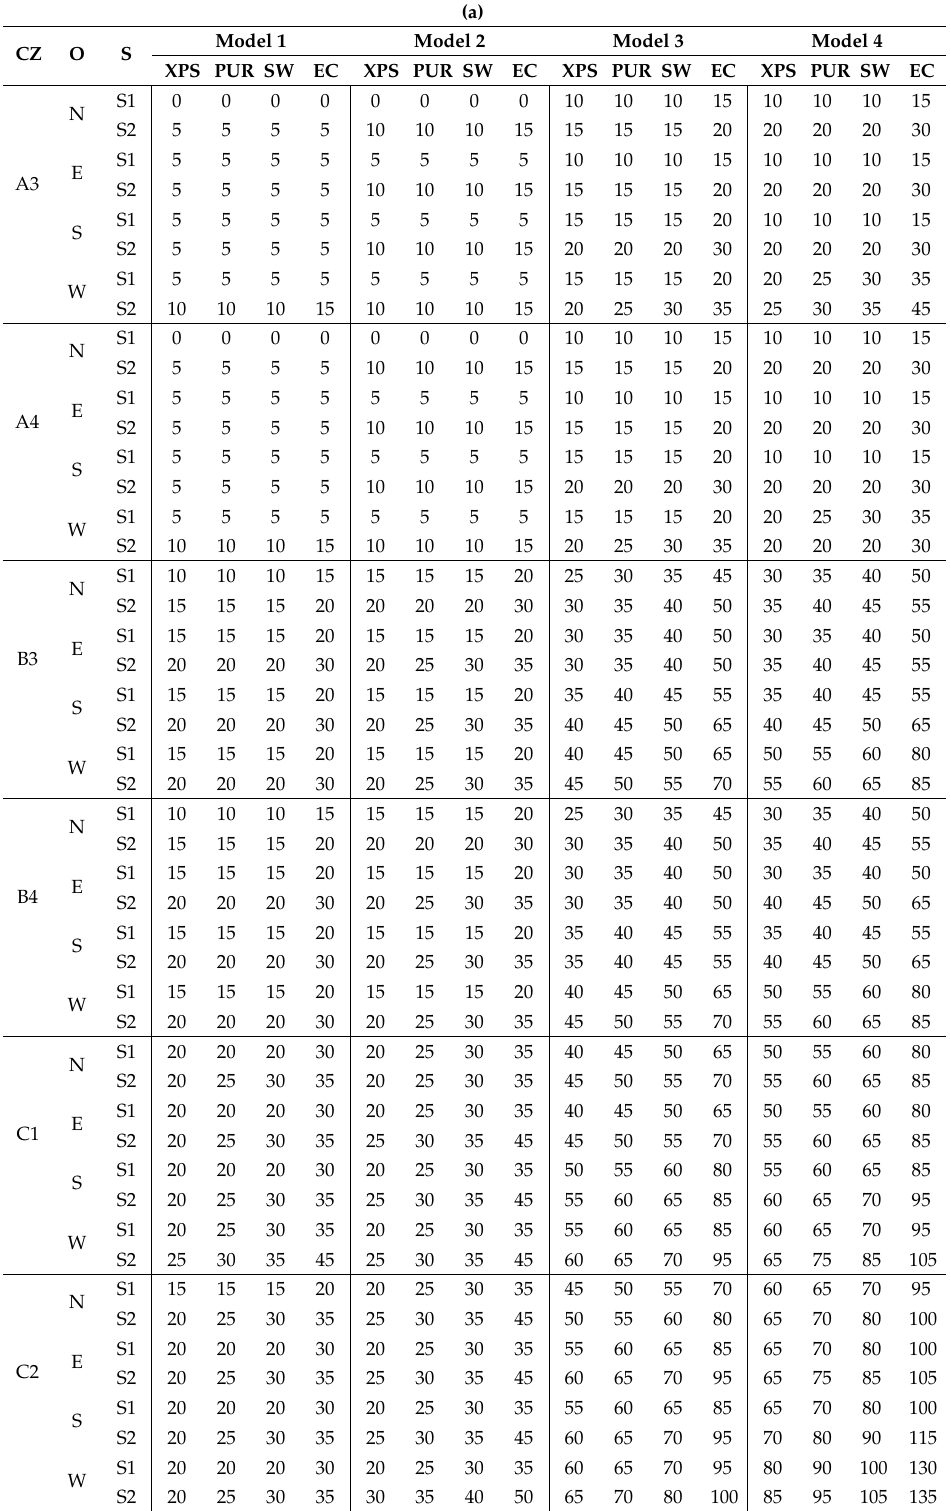
Table A2. Insulation thicknesses (in mm), for Hypothesis 2: Joint (heating + cooling) demand ≤